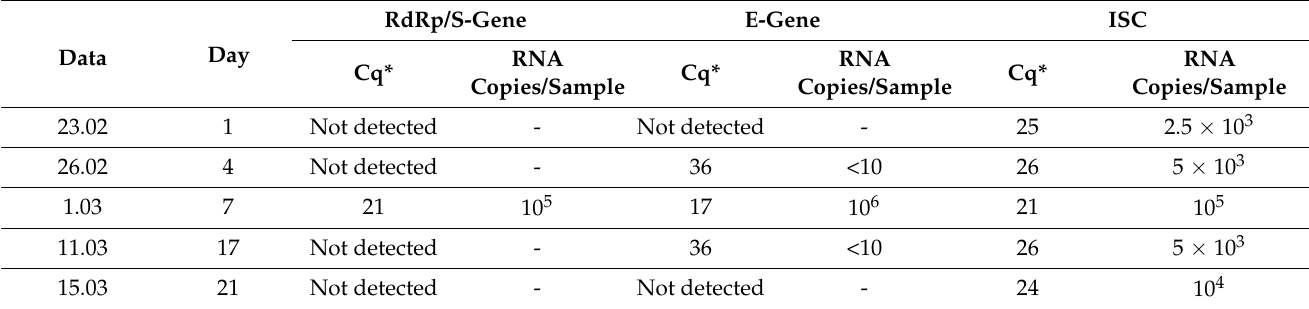
Table 1. Results of RT-qPCR Analysis of Selected Genes during the SARS-CoV-2 Infection.